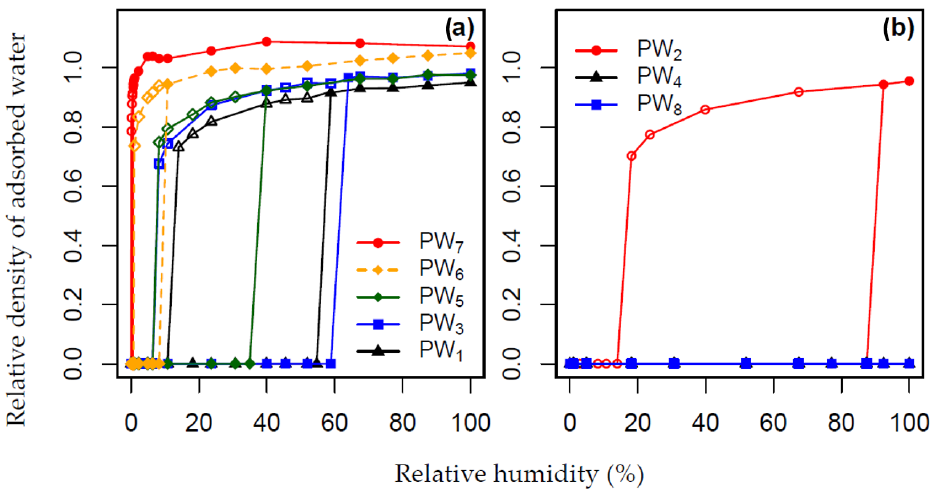
Figure 4. Simulated water sorption isotherms from eight types of 0.95 nm cell wall pores at 25 °C with different WWIS. ( a ) PW 1 , PW 3 , PW 5 , PW 6 and PW 7 ; ( b ) PW 2 , PW 4 and PW 8 . Solid symbols, adsorption; open symbols, desorption.